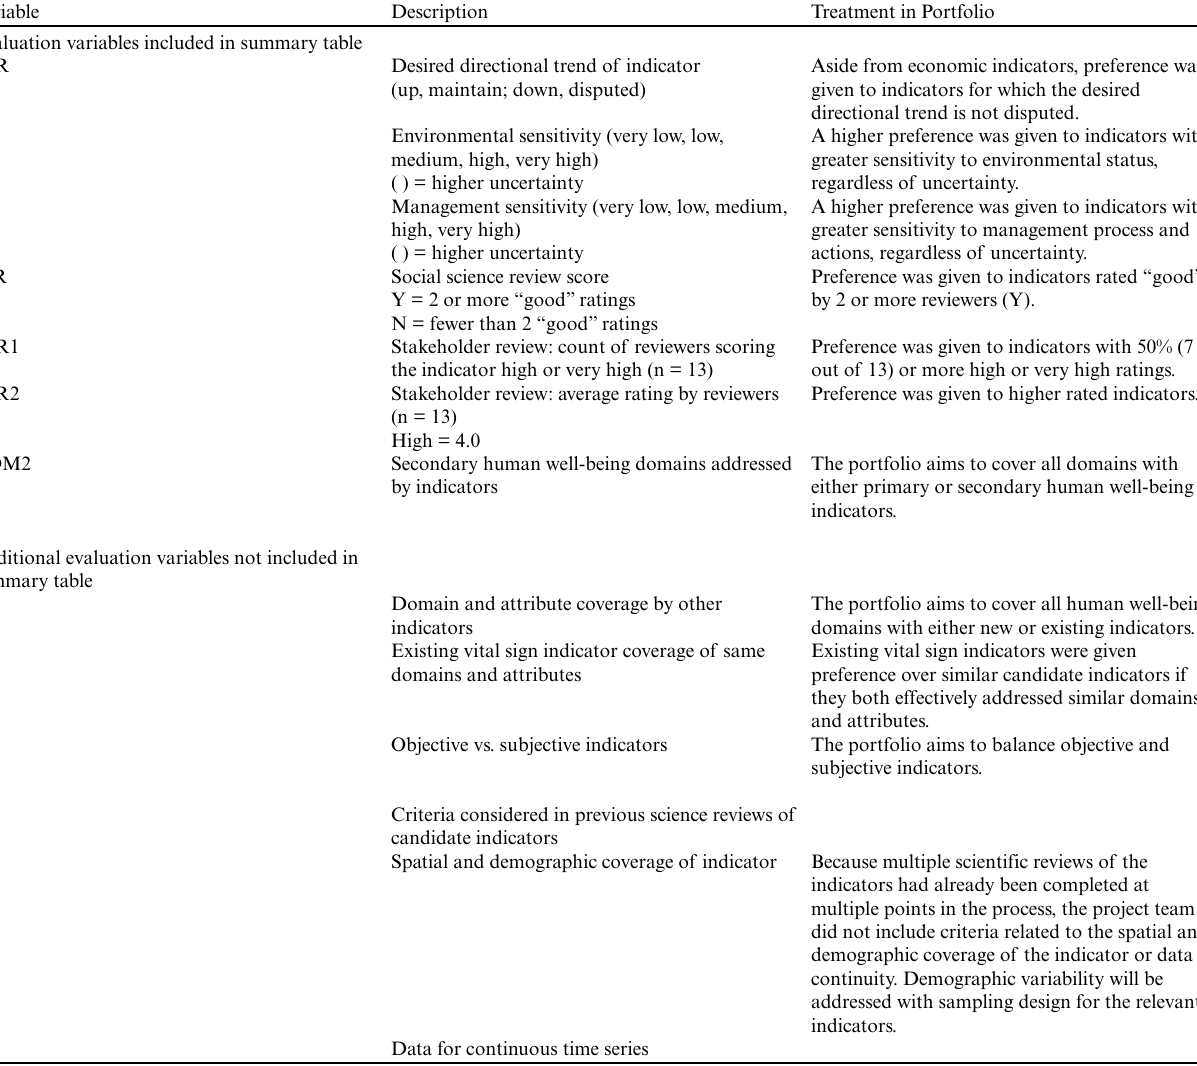
Table 3 . Criteria for final selection of